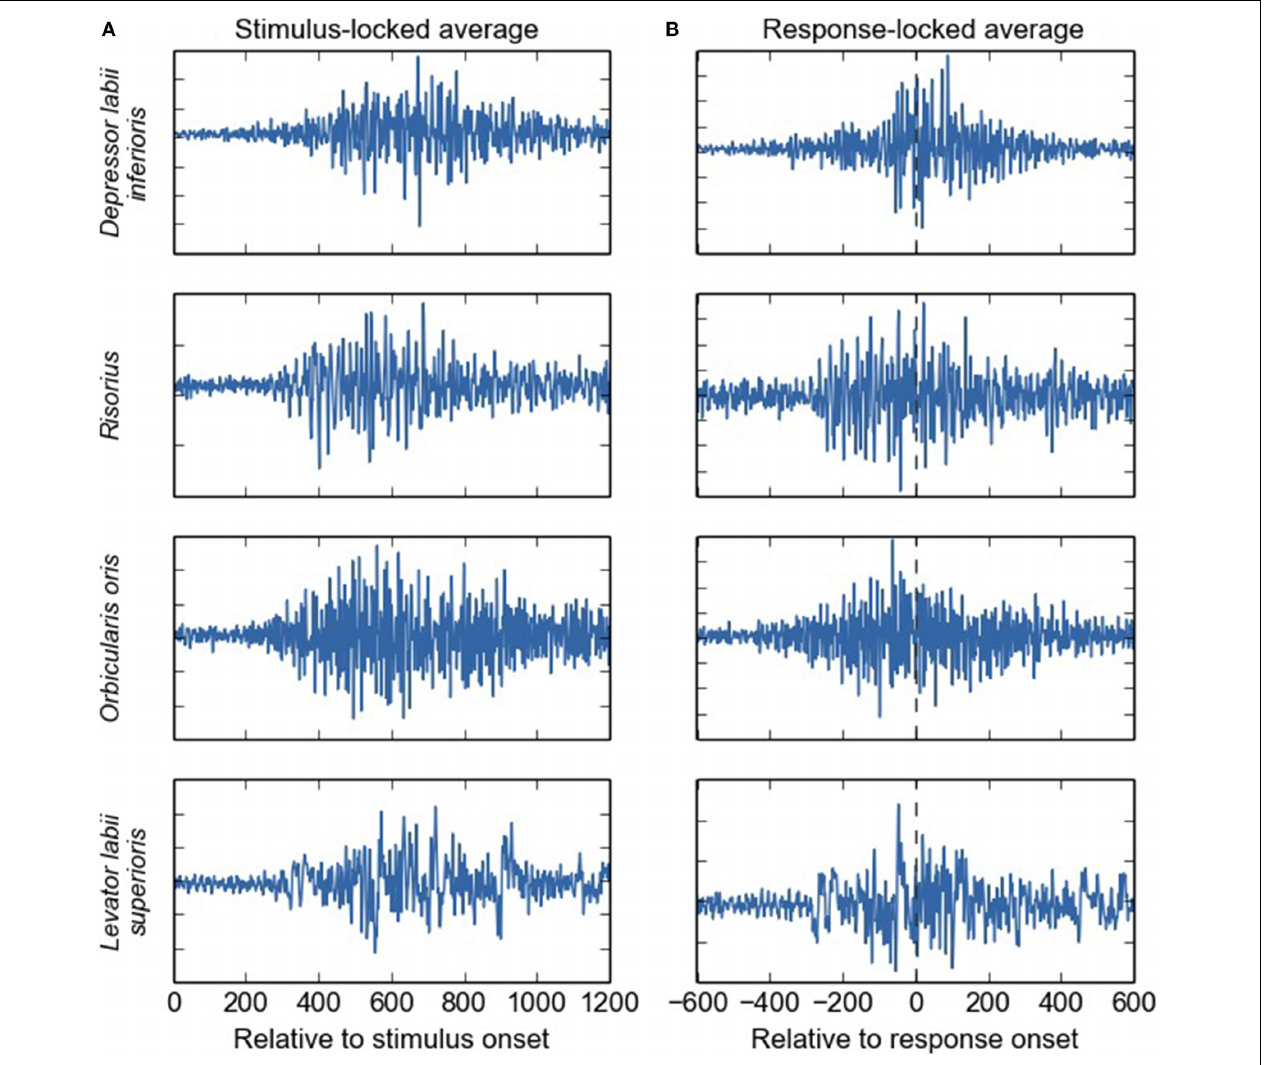
FIGURE 5 | Average EMG waveforms for four different facial muscles (in arbitrary units), event-locked on the stimulus (A) and on the response onset (B). Substantial EMG activity is present during a large part of the stimulus-response time-window, and not only shortly around the response event. We deliberately chose to average raw, instead of rectified, EMG signals, even though this will cause anti-phase activities to cancel out. We